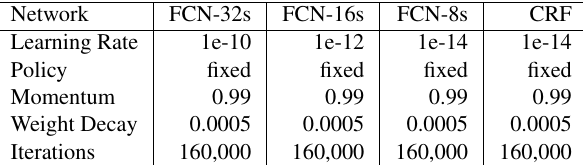
Table 4. Summary of the parameters used for the individual training stages.